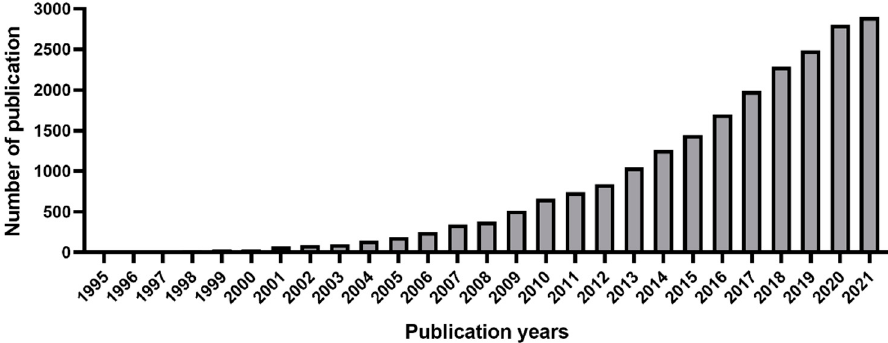
Figure 1. Total number of publications per year with “3D culture” topic. Source: Web of Science: Science Citation Index Expanded [13] .